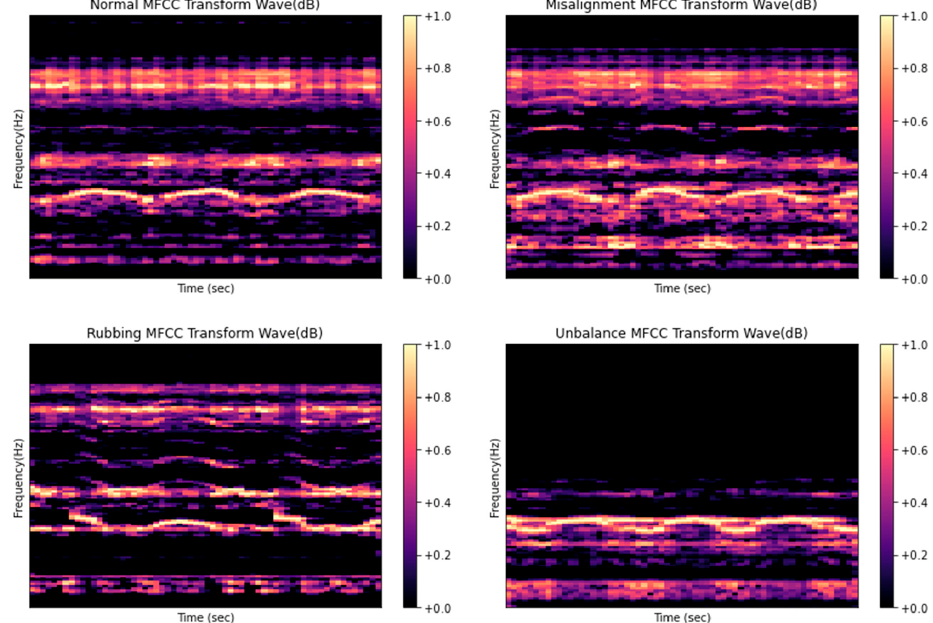
Figure 7. Example of signal changes in the spectrograms of the Mel Frequency Cepstral Coefficients (MFCC) signals.